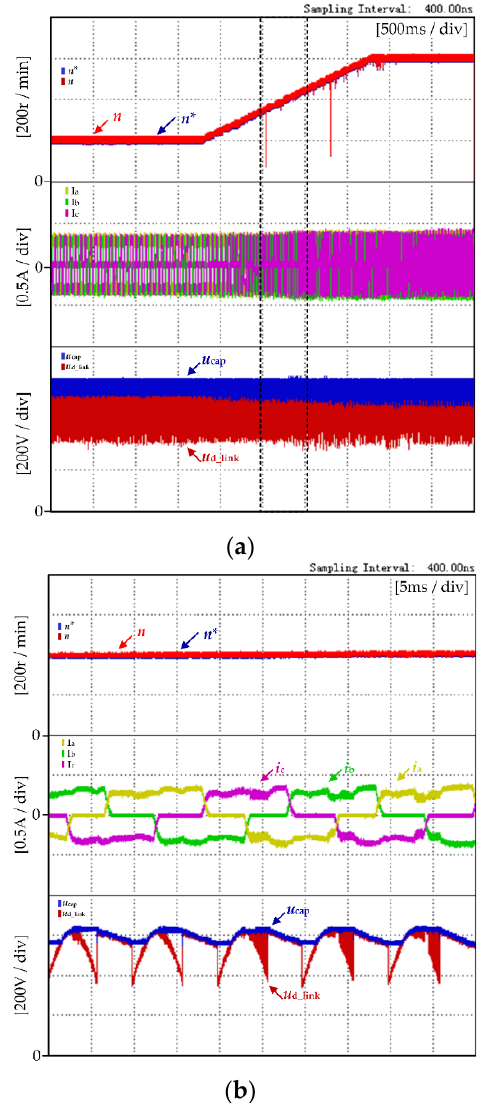
Figure 12. Dynamic response of speed variation in the proposed strategy ( T L = 0.89 N·m): ( a ) overall view; ( b ) enlarged view.